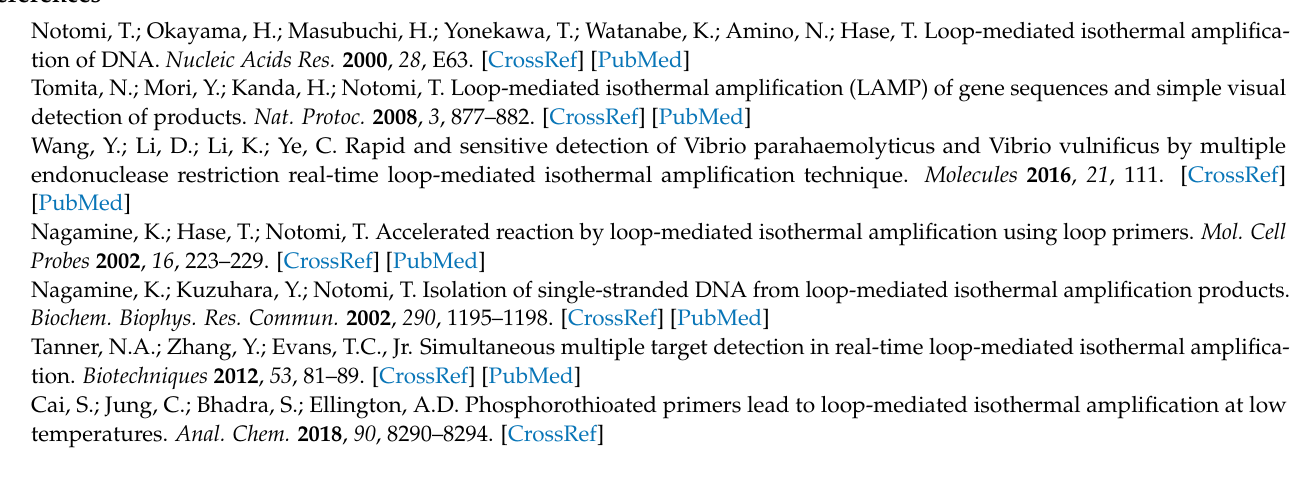
nGO concentrations; Figure S2: Real-time fluorescence monitoring of conventional LAMP reactions (- PEG-nGO) with serially diluted target cDNA concentrations.; Figure S3: Tt values of positive and negative HCV clinical samples in the presence of various amounts of Bst DNA polymerase with PEG-nGO.; Figure S4: Real-time fluorescence monitoring of LAMP reactions for 20 clinical samples with 10 positive (solid line) and 10 negative (dashed line) in the presence of